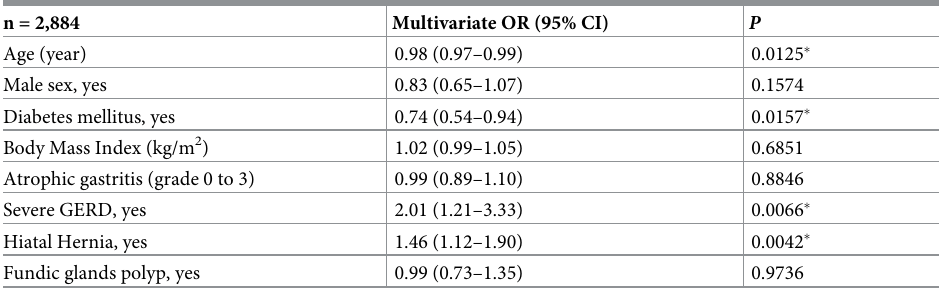
Table 4. Associated factors for positive GSRS score of acid